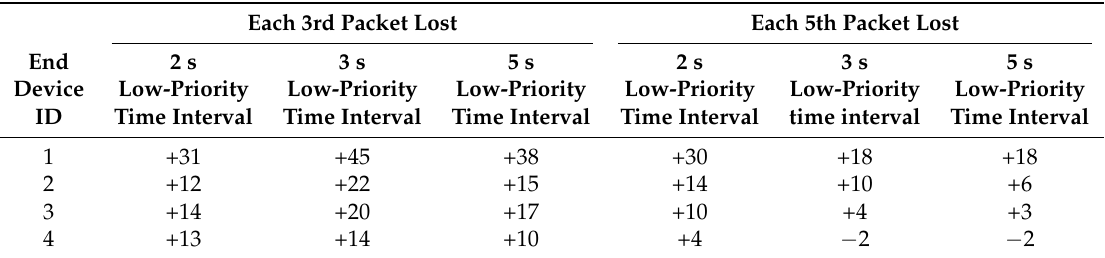
Table 8. Time comparison (in minutes) of the two simulation modes for congestion conditions. Each 3rd Packet Lost Each 5th Packet Lost